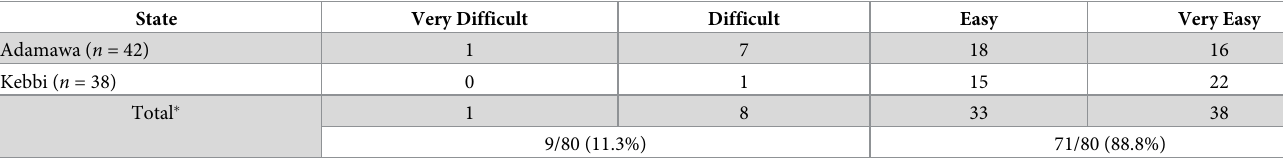
Table 6. Kebbi and Adamawa spot check data indicating perceived ease of MNP usage. State Very Difficult Difficult Easy Very